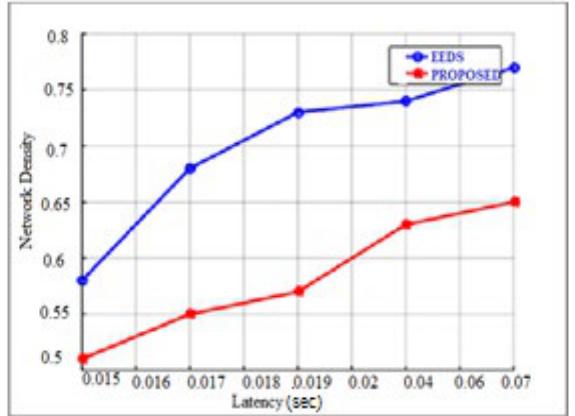
Table 8. Comparison Values of